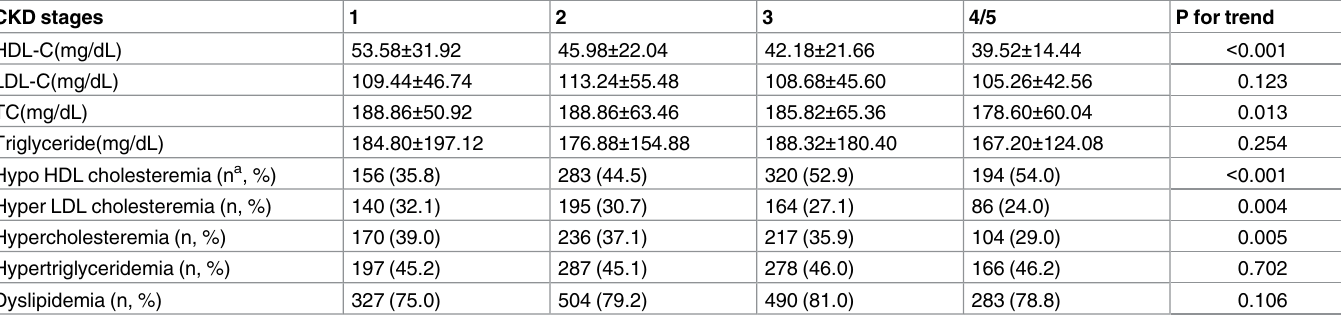
Table 2. Levels of different serum lipid components and incidences of different types of dyslipidemia in different CKD stages. HDL—C indicates high-density lipoprotein cholesterol; LDL-C low-densitylipoproteincholesterol; TC total cholesterol.